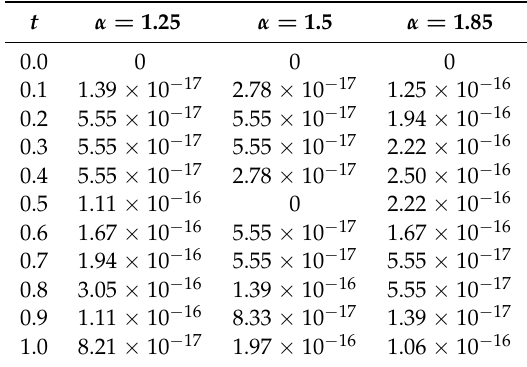
Table 6. The absolute errors with m = 3 and α > 1 for Example